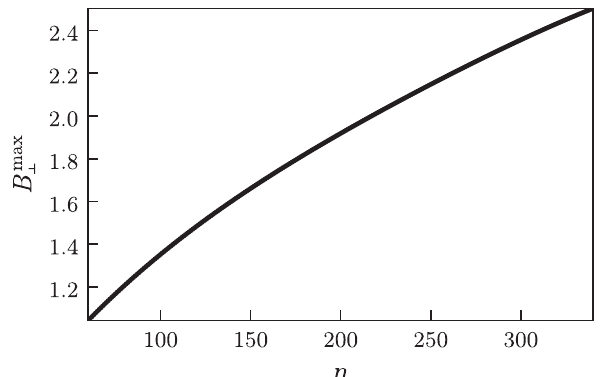
FIG. 8. Plot of the maximum value of the transverse field at midresonance point B max ⊥ as a function of n . We define ≃ n= ð n − 2 p Þ satisfies B max ⊥ ¼ ð B ⊥ B ⊥ = 2 , where B ⊥ p þ p þ 1 Þ ;p n − 2 p Þ and the integer p is equal the equation E ð 0 Þ ¼ − B ⊥ ;k ð to its maximum possible value p ¼ p for which the max